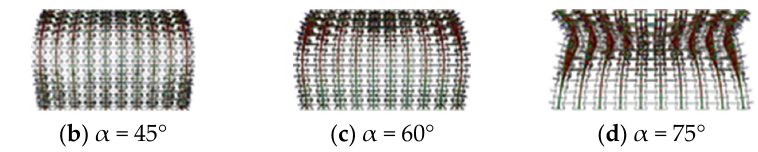
Figure 10. Deformation at different angles at speed of 3 m/s ( ε = 0.186). When the cell angle α = 30 ◦ , the impact energy is first transferred from the upper of the specimen to the lower. Shrinkage deformations in the vertical direction are produced in the middle part. The shrinkage deformation of the lower part of the specimen is greater than that of the upper part of the specimen. The deformation mode of this case is that the deformation is small near the upper end and the deformation is great next to the lower